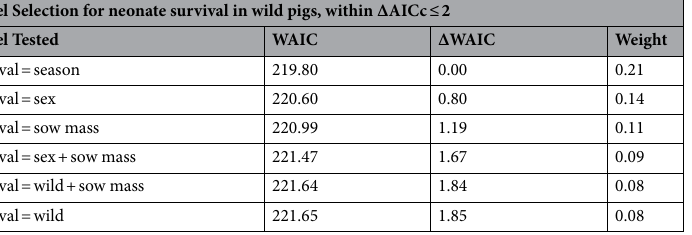
Table 2. Set of competing models (within ΔWAIC ≤ 2 of the top model) that include neonate, sow and environmental covariates influencing wild pig ( Sus scrofa ) neonate survival to six weeks on the Savannah River Site, Aiken, Allendale, and Barnwell counties, SC USA, 2017–2020. Variables included in model selection analyses: litter, litter size; season, season neonate was born (cold = December-15 March or warm = 16 March- September); sex, neonate sex (male or female); sow mass, neonate mass at capture; wild, wild pelage